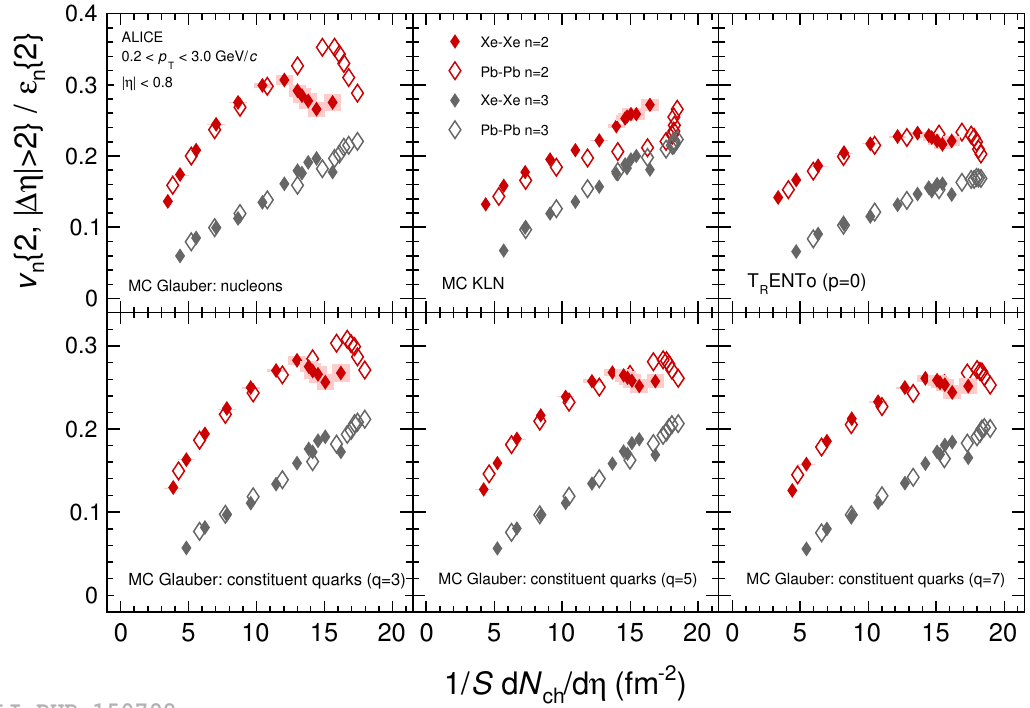
Figure 2. v n { 2, | ∆ η > 2 |} / ε n { 2 } as a function of transverse density in Xe–Xe and Pb–Pb for n = 2 and n = 3, for various IS models. ( Top left ) MC Glauber using nucleons as sources [11]. ( Top centre ) MC KLN [12]. ( Top right ) T R ENTo [7]. ( Bottom ) MC Glauber using 3, 5, and 7 constituent quarks as sources [11],